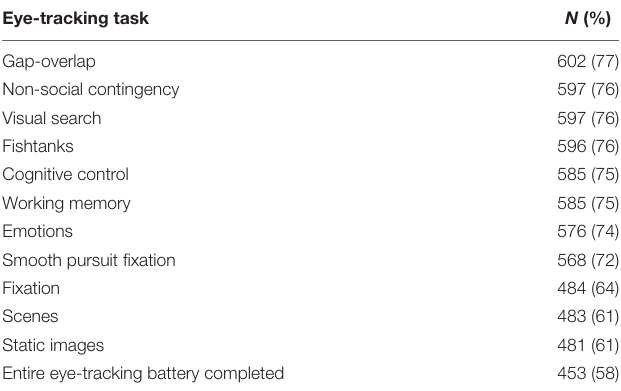
TABLE 3 | Tests and completion rates for eye tracking